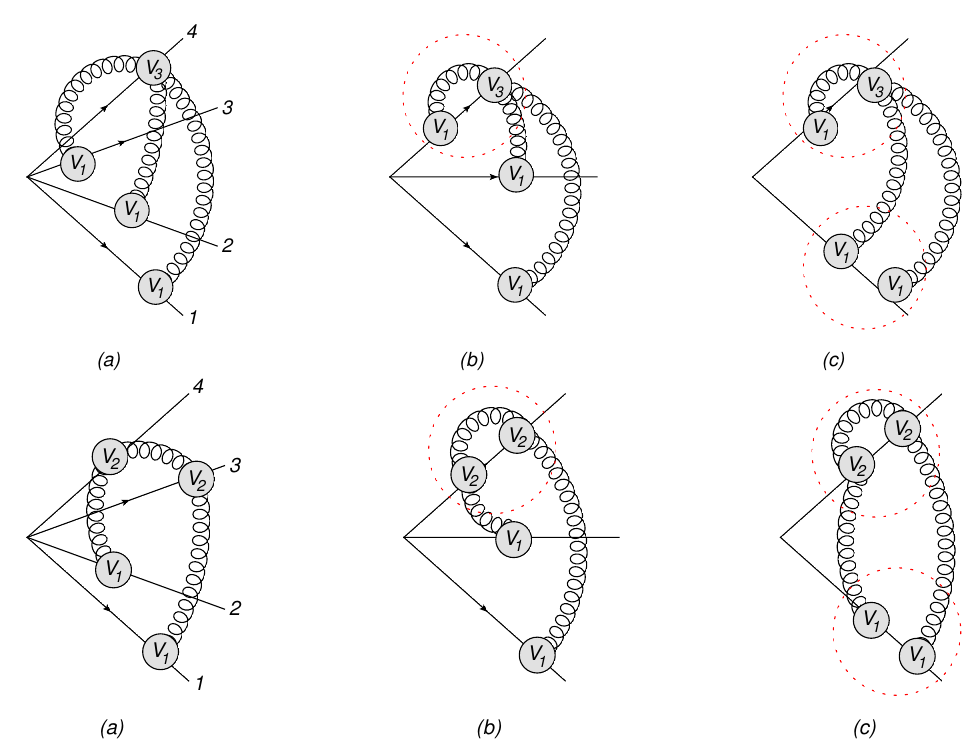
Figure 17 . Upper diagrams: (a) Effective vertex diagram for the (1,1,1,3) web; (b) Contribution to the (1,1,4) web obtained from collinear reduction of (a); (c) Contribution to the (2,4) web obtained from collinear reduction of (b). The red circle denotes symmetrisation of vertices. Lower diagrams: the same starting with the 1122